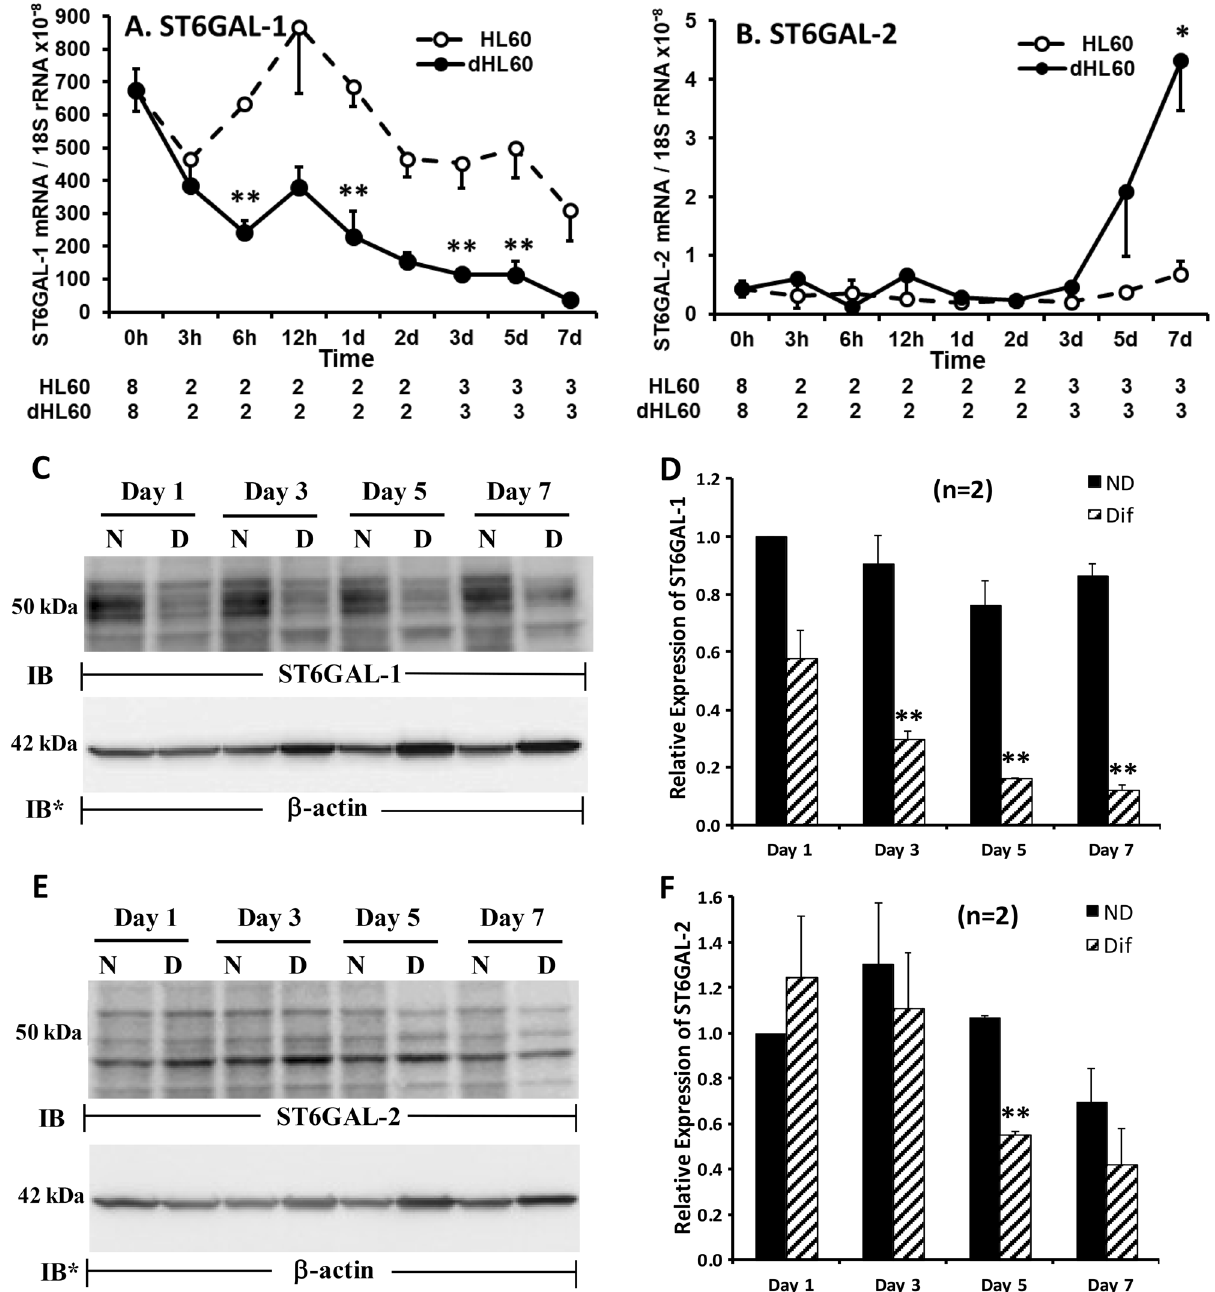
Figure 9. ST6GAL-1 and ST6GAL-2 Expression During HL60 Cell Differentiation. ( A , B ) Total RNA isolated from HL60 cells cultured for 0, 3, 6, and 12 h and 1, 2, 3, 5, and 7 days in the presence of DMF or medium alone was processed for qRT-PCR for human ST6GAL-1 ( A ) and ST6GAL-2 ( B ) mRNA levels. The mRNA levels for each ST was normalized to the 18S rRNA internal control. Each symbol represents mean ± SE normalized mRNA levels for each time point. n for each data point is indicated below each time point. ( C , E ) HL60 cells were cultured for 1, 3, 5, or 7 days in the presence of DMF or medium alone, lysed, and the lysates, at 50 µg total cellular protein/lane, were processed for ST6GAL-1 ( C ) and ST6GAL-2 ( E ) immunoblotting. To control for protein loading and transfer, blots were stripped and reprobed for β-actin. IB, immunoblot; IB*, immunoblot after stripping. MW in kDa is indicated on the left. ( D , F ) Densitometric analyses of the blots in ( C and E ), respectively. Vertical bars represent mean ± SE ST6GAL-1 and ST6GAL-2 signal normalized to β-actin signal in the same lane on the same stripped and reprobed blot. *, increased normalized ST6GAL-2 signal in dHL60 cells compared to HL60 cells at p < 0.05. **, decreased normalized ST6GAL-1 or ST6GAL-2 signal in dHL60 cells compared to HL60 cells at p < 0.05. The data generated in each panel represents experiments performed on ≥ 2 independent